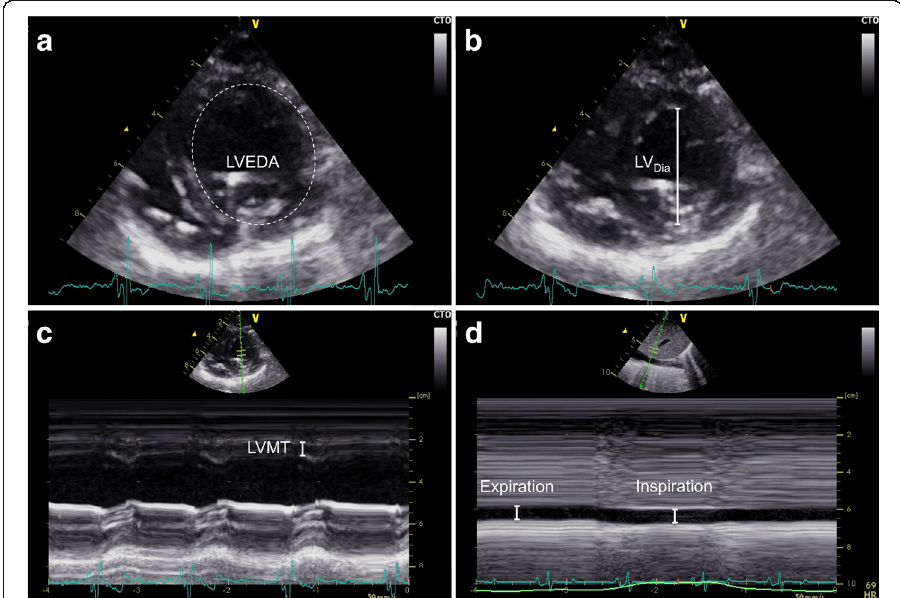
Fig. 1 Ultrasonographic data acquisition. Ultrasonographic images of the left ventricle obtained from a parasternal short-axis view. Endocardial tracing allowed for measurement of left ventricular end-diastolic area (LVEDA) ( a ), left ventricular systolic diameter (LV Dia ) ( b ) and left ventricular myocardial thickness (LVMT) ( c ) to enable afterload calculation. Inferior vena cava diameter was measured with anatomical M-mode